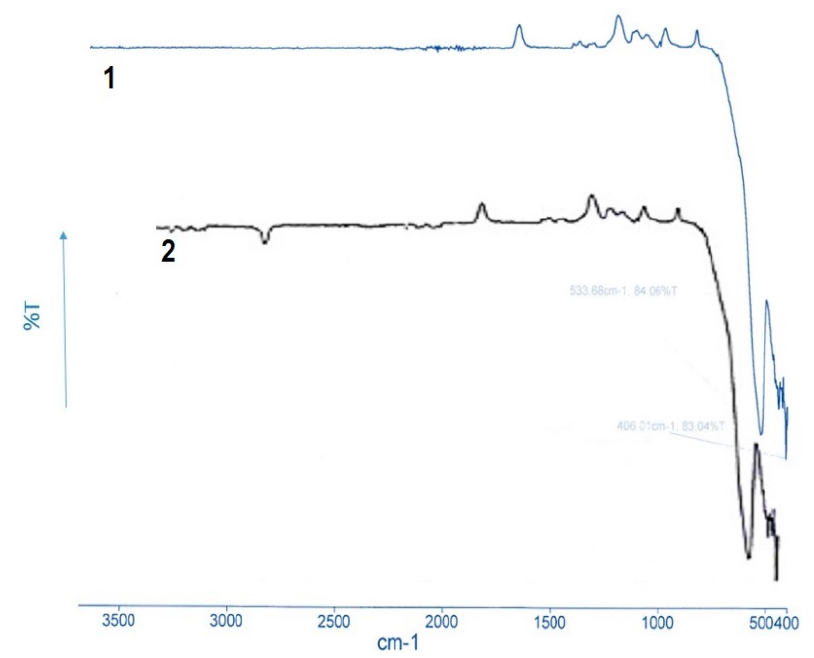
Figure 19. FTIR spectra of Co 0.1 Al 0.03 Fe 0.17 O 4 before ( 1 ) and after 5 cycles ( 2 ) using as photocatalyst. Different photocatalysts have been reported in the literature for the purpose of photodegradation of methylene blue. The competency of aluminum ‐ doped cobalt ferrite was found